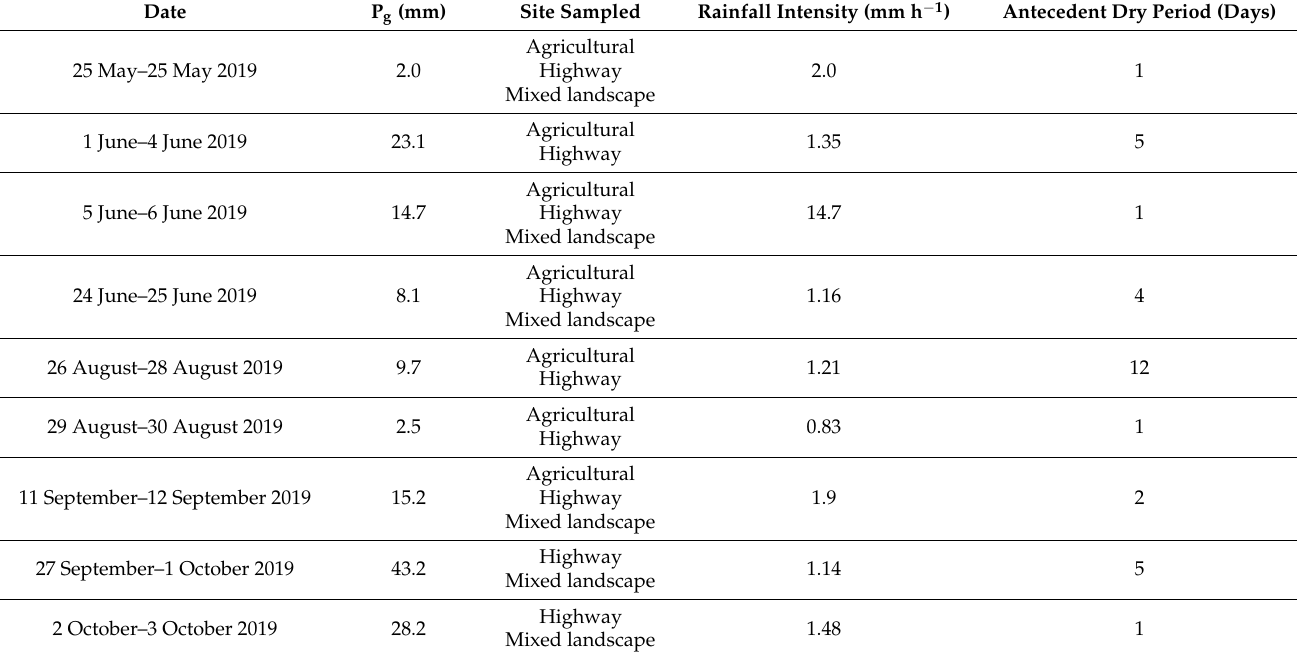
Table 2. Total precipitation (P g ), rainfall intensity, and antecedent dry period for the study